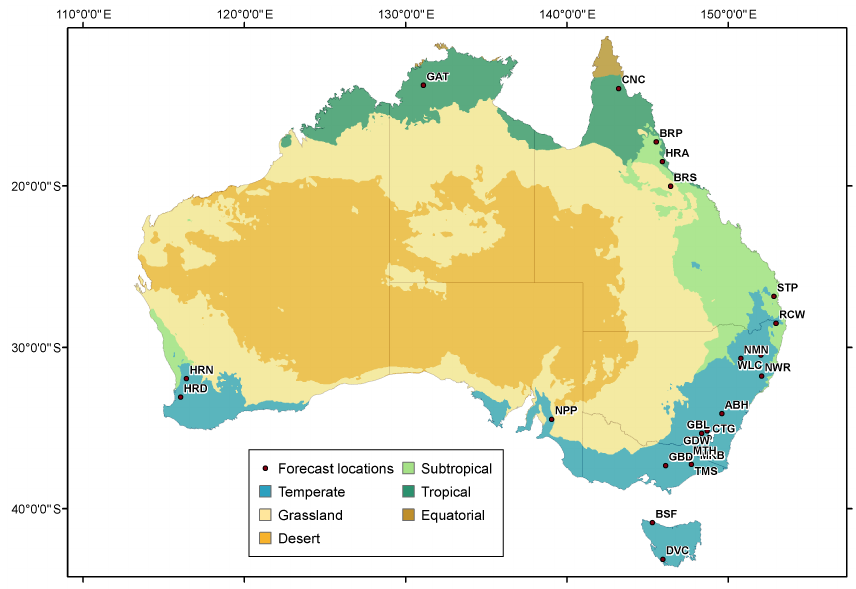
Figure 1. The 23 forecast locations and their climate zones. The locations are current Bureau of Meteorology seasonal streamflow forecast